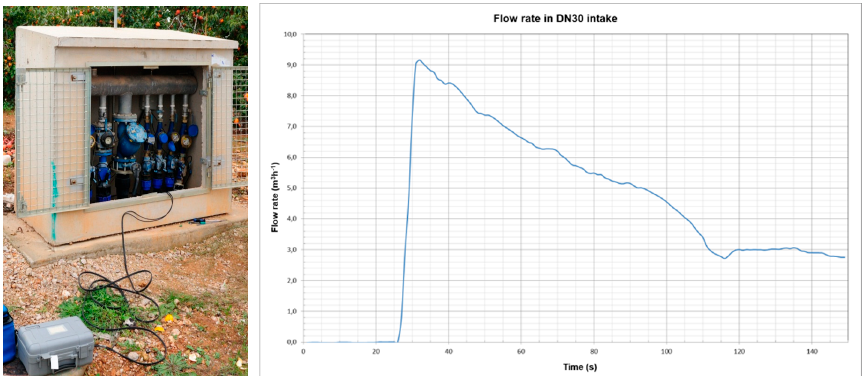
Figure 8 . Water meter blocking test in the field. Figure 8. Water meter blocking test in the